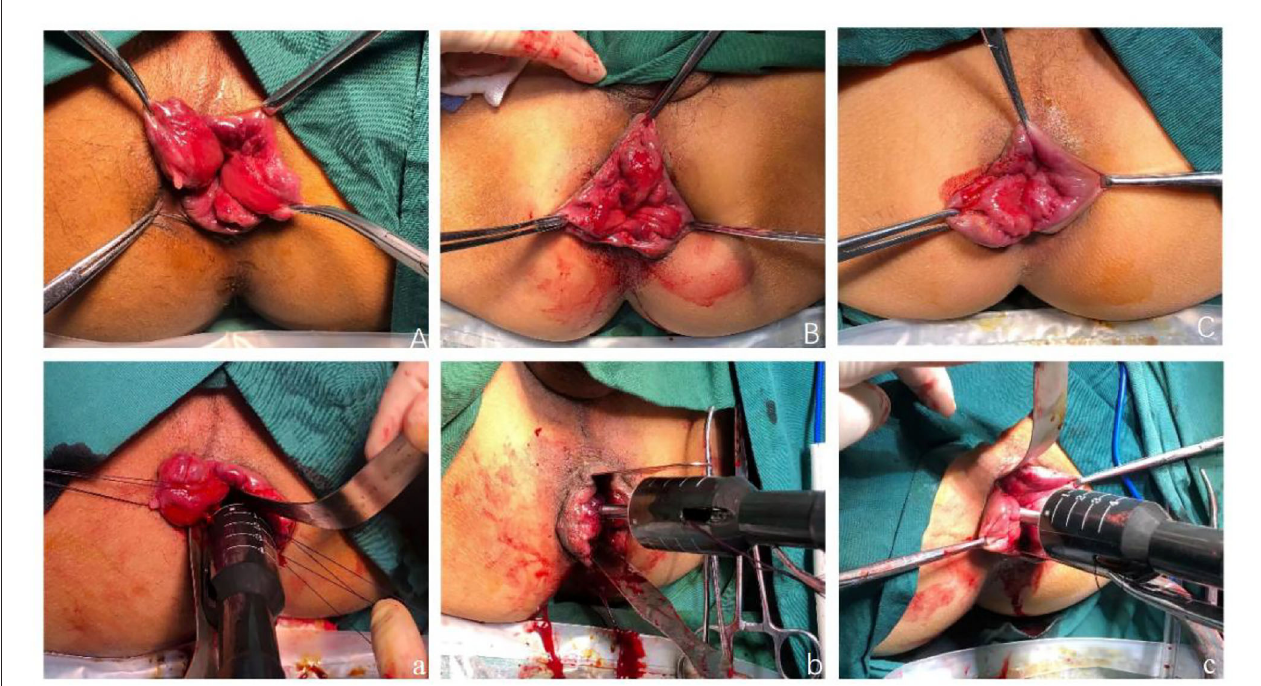
FIGURE 2 | (A) The left anterior and right posterior mucosal membranes were retained. The preoperative pictures of the patients in (a). (B) The anterior and posterior mucosal membranes were retained. The preoperative pictures of the patients in (b). (C) The right mucosa membrane was retained. The preoperative pictures of the patients in